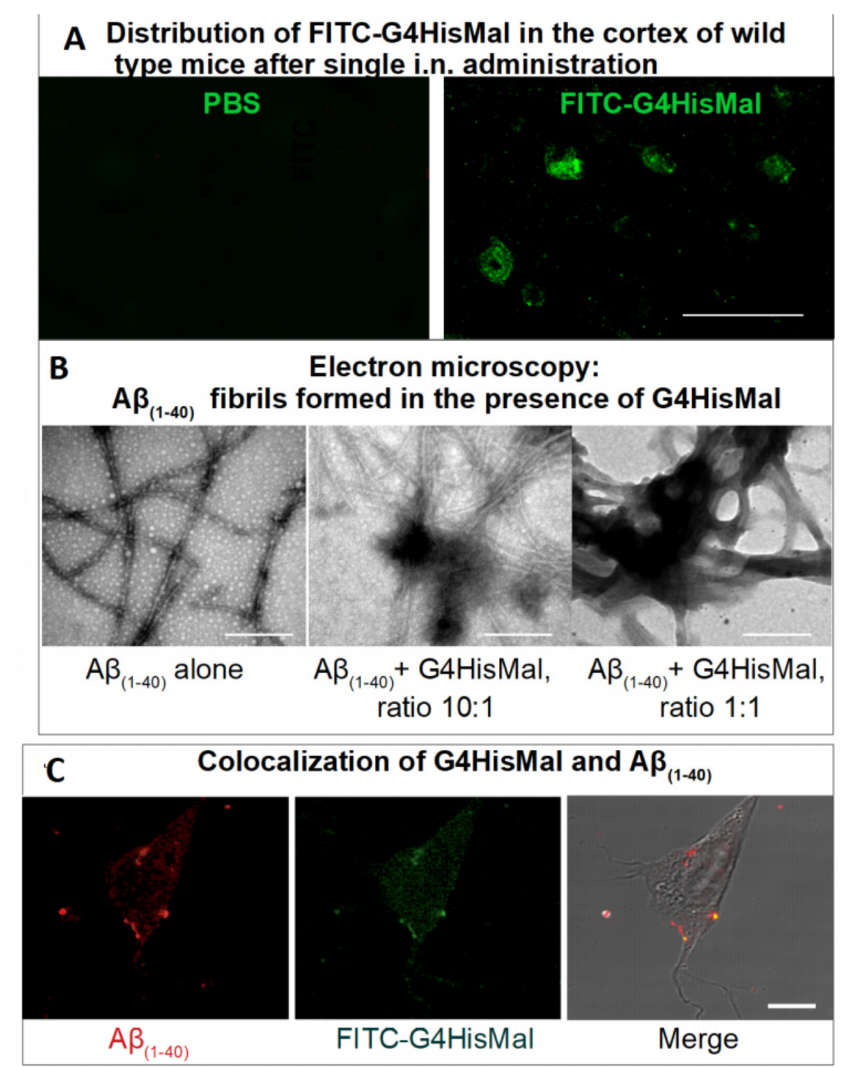
Figure 11. G4HisMal dendrimers cross the BBB and inhibit A β (1–40) -induced cell toxicity. ( A ) Fluorescence microscopy images show the presence of FITC –G4HisMal in the cortex after i.n. administration of FITC–G4HisMal. The bar is 10 µ m. ( B ) Transmission electron microscopy (TEM) of A β fibrils. Bar = 100 nm. ( C ) Colocalization of FITC–G4HisMal dendrimers with A β (1–40) in SH-SY5Y cells. SH–SY5Y cells were treated with 10 µ mol A β (1–40) and 1 µ mol G4HisMal after 24 h of incubation, then cells were fixed and labeled with specific antibodies against A β (1–40) (red) 1 µ mol and FITC against FITC-labeled dendrimers (green). Merge shows co-localization of A β (1–40) and FITC–G4HisMal. A β (1–40) fibrils and monomers were used as controls. Reprinted with permission from ref. [178]. Copyright 2019, Elsevier